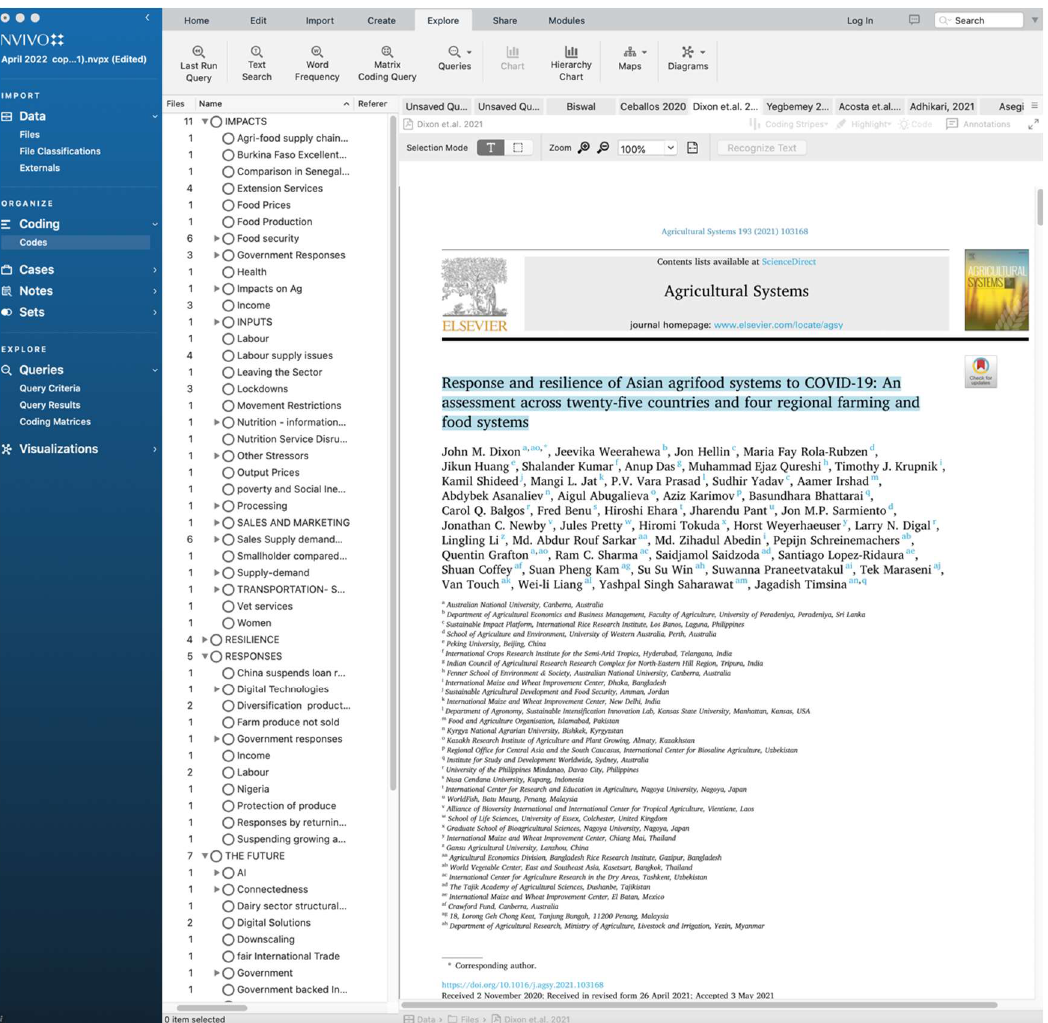
Figure 2. NVIVO code development.